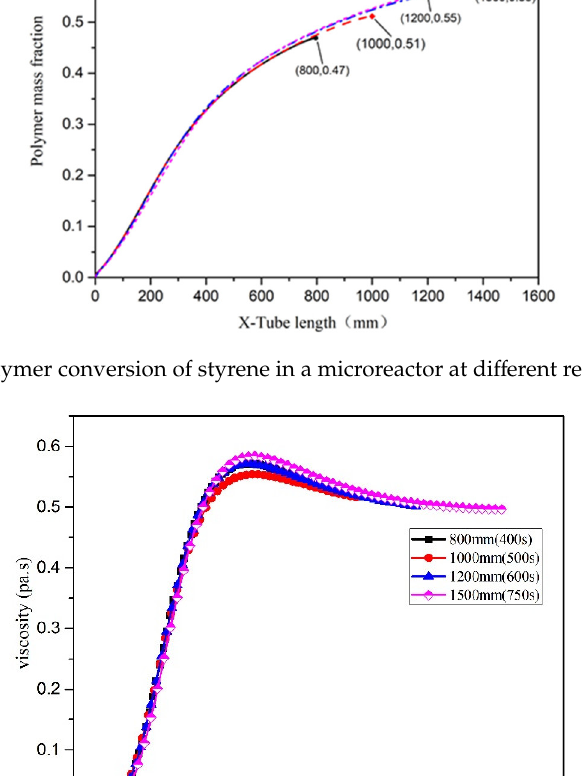
Figure 23. Temperature curve of the central axis of microreactors with different residence times.